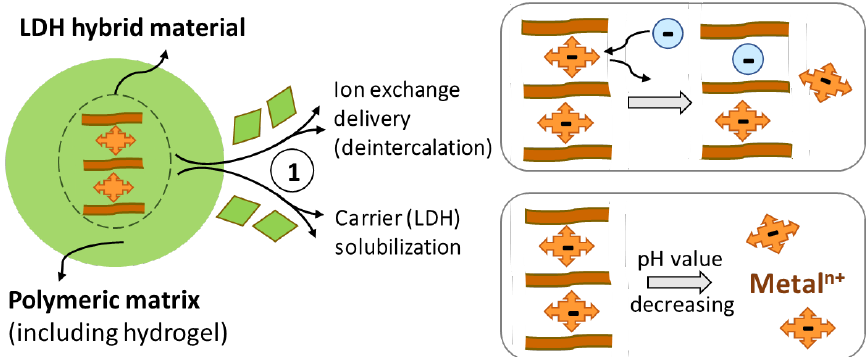
Figure 15. Mechanisms for the drug delivery from DDS based on polymer/LDH nanocomposites.